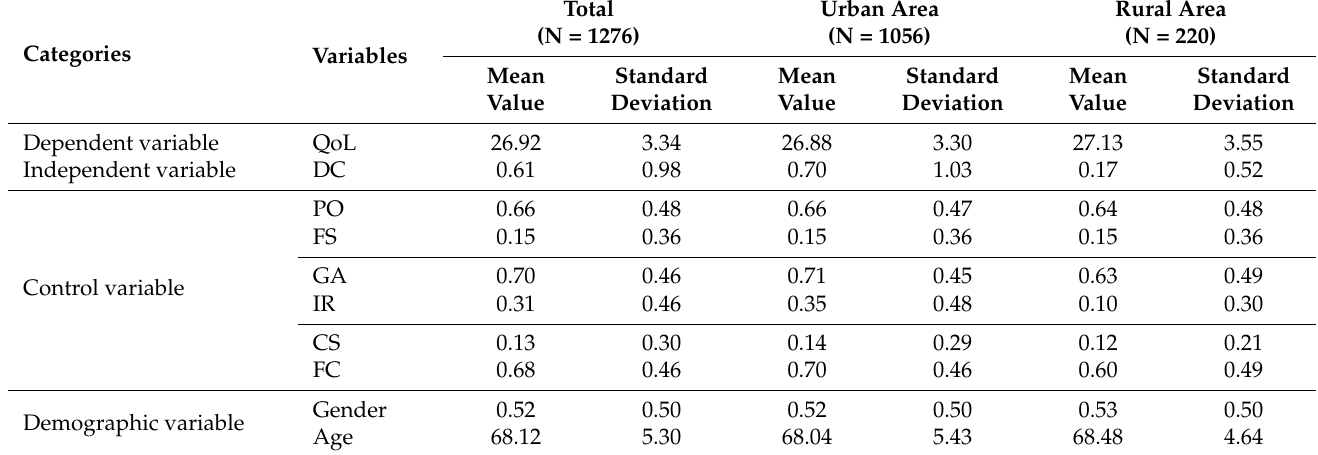
Table 6. Descriptive statistics of the characteristic variables of older